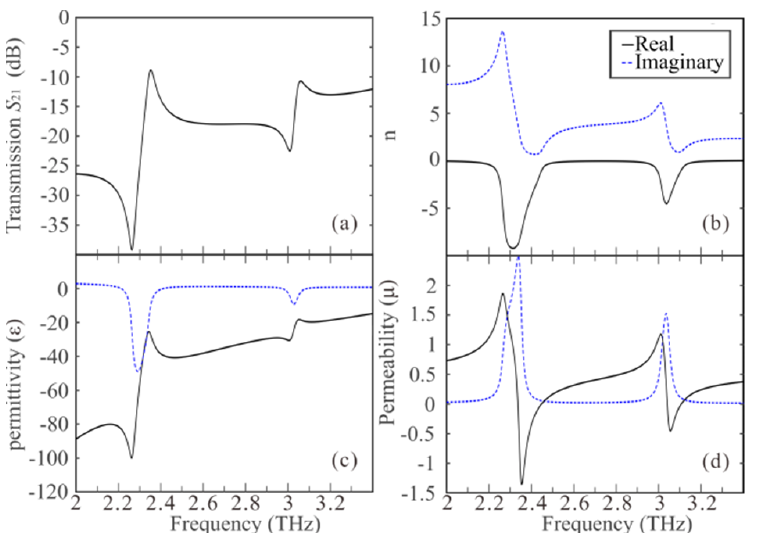
Figure 2. The ( a ) transmission coefficient S 21 , ( b ) effective refraction index n , ( c ) permittivity ε , and ( d ) permeability µ of single-layer LHMs. In ( b , c ), the real and imaginary parts are depicted by solid and dashed curves, respectively.